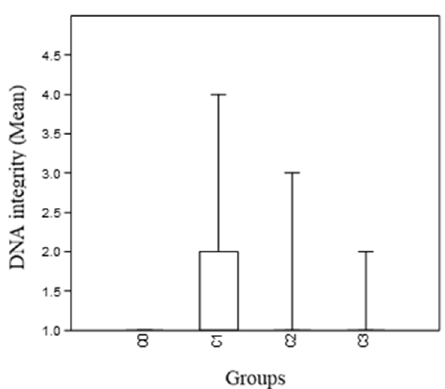
Figure 4. Boxplot for DNA integrity means in the different experimental groups.